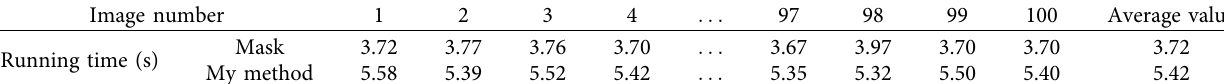
Table 2: Time required for dodging.